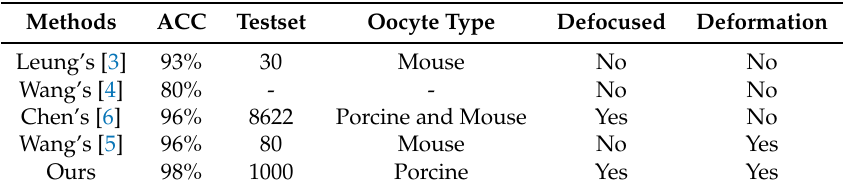
Table 3. Comparison of previous polar-body methods and our